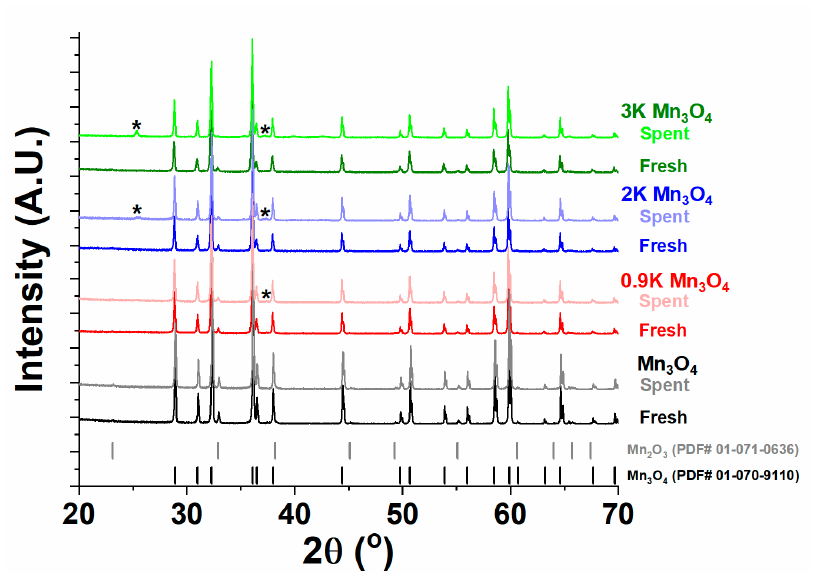
Figure 7. X-ray diffraction patterns of fresh and spent Mn 3 O 4 catalysts with varying K loadings. Short vertical lines indicate the position of reflections of Mn 3 O 4 (PDF# 01-070-9110) and Mn 2 O 3 (PDF# 01-071-0636) for reference. Asterisks indicate reflections related to the presence of an additional potassium–manganate oxide phase in spent K-containing samples.